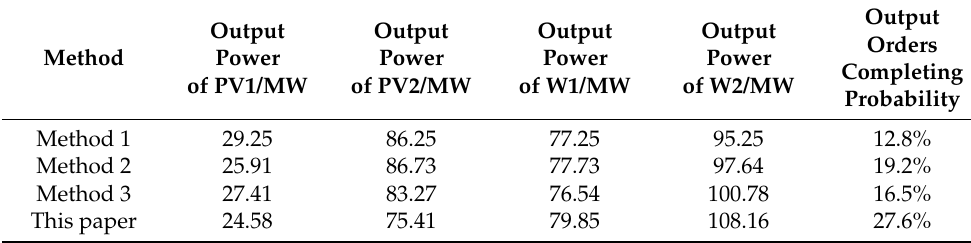
Table 4. Comparison of margin allocation